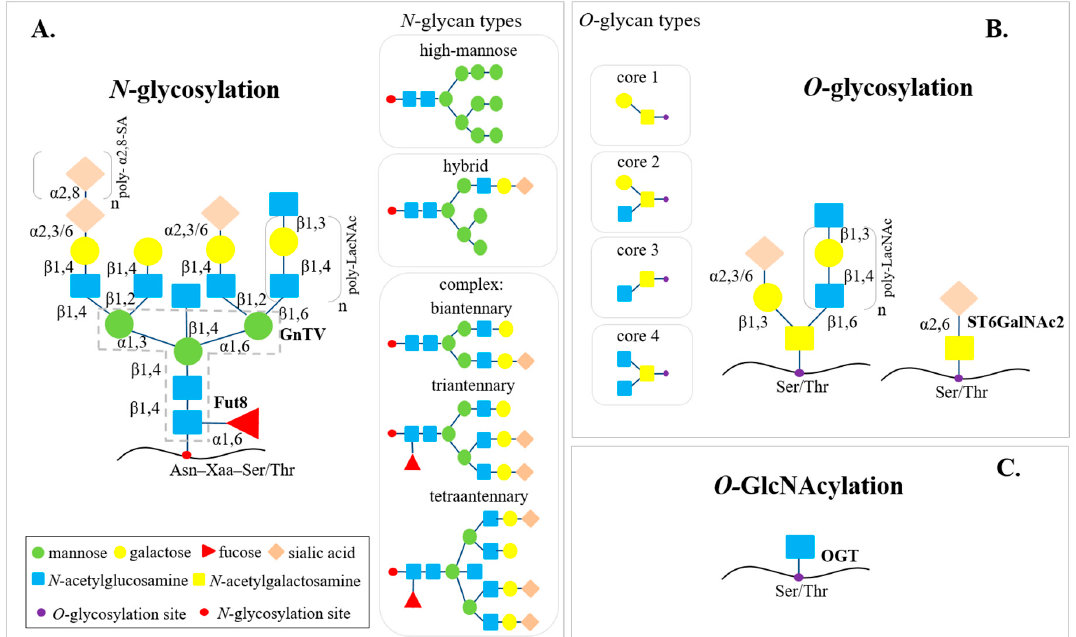
Figure 1. Three post-translational modifications of proteins: N -glycosylation, O -glycosylation and O -GlcNAcylation. ( A ) N -oligosaccharides are attached via N -glycosidic bonds to asparagine (Asn) in